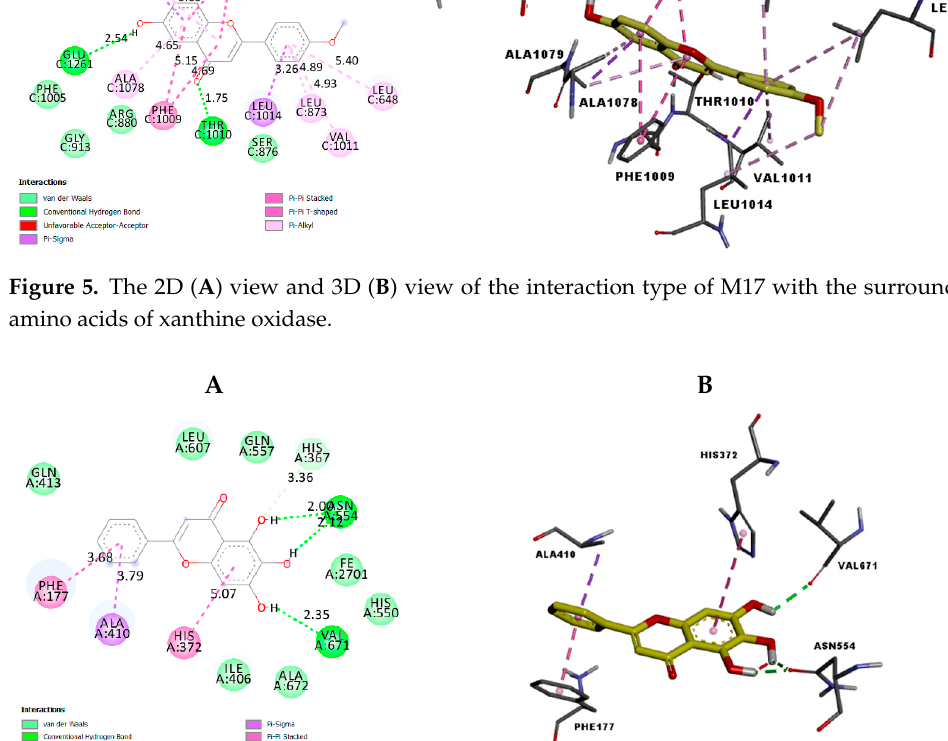
Figure 6. The 2D ( A ) view and 3D ( B ) view of the interaction type of M7 with the surrounding amino acids of 15-lipoxygenase.